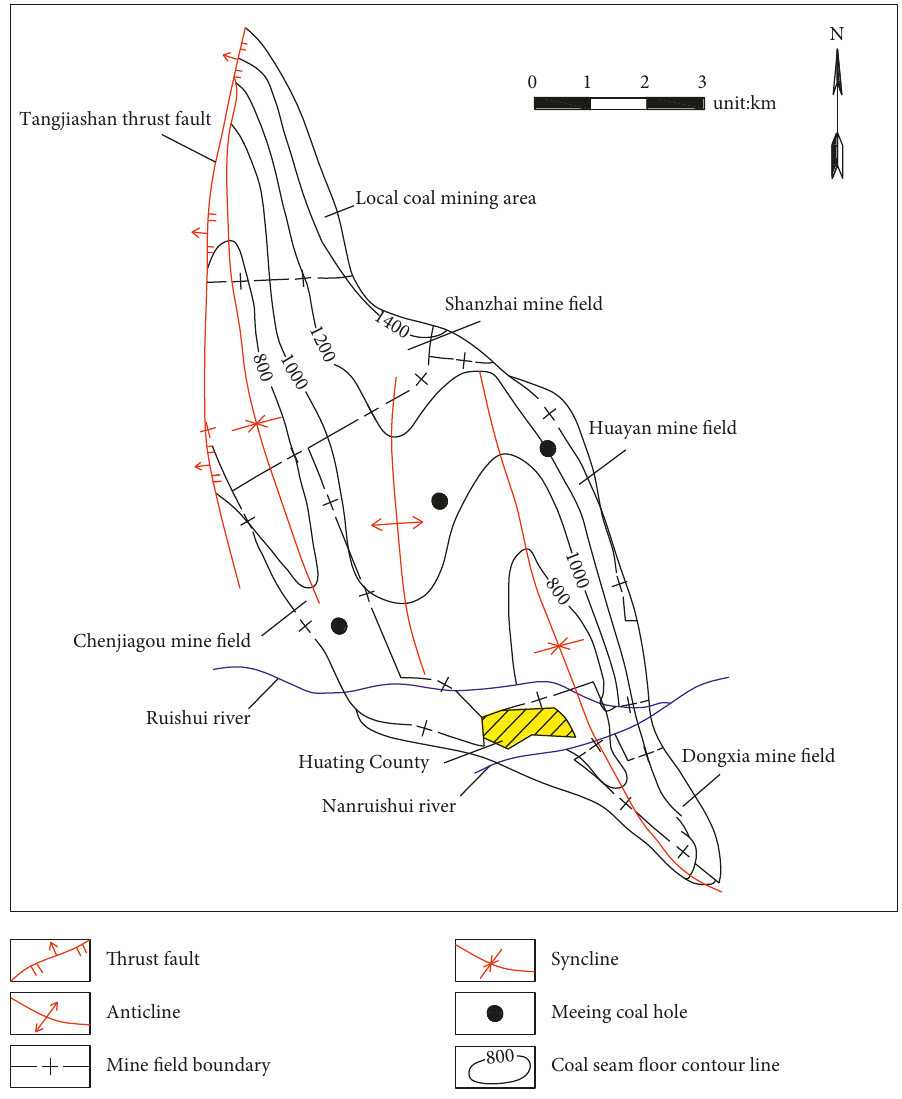
Figure 1: The plan of whole coal